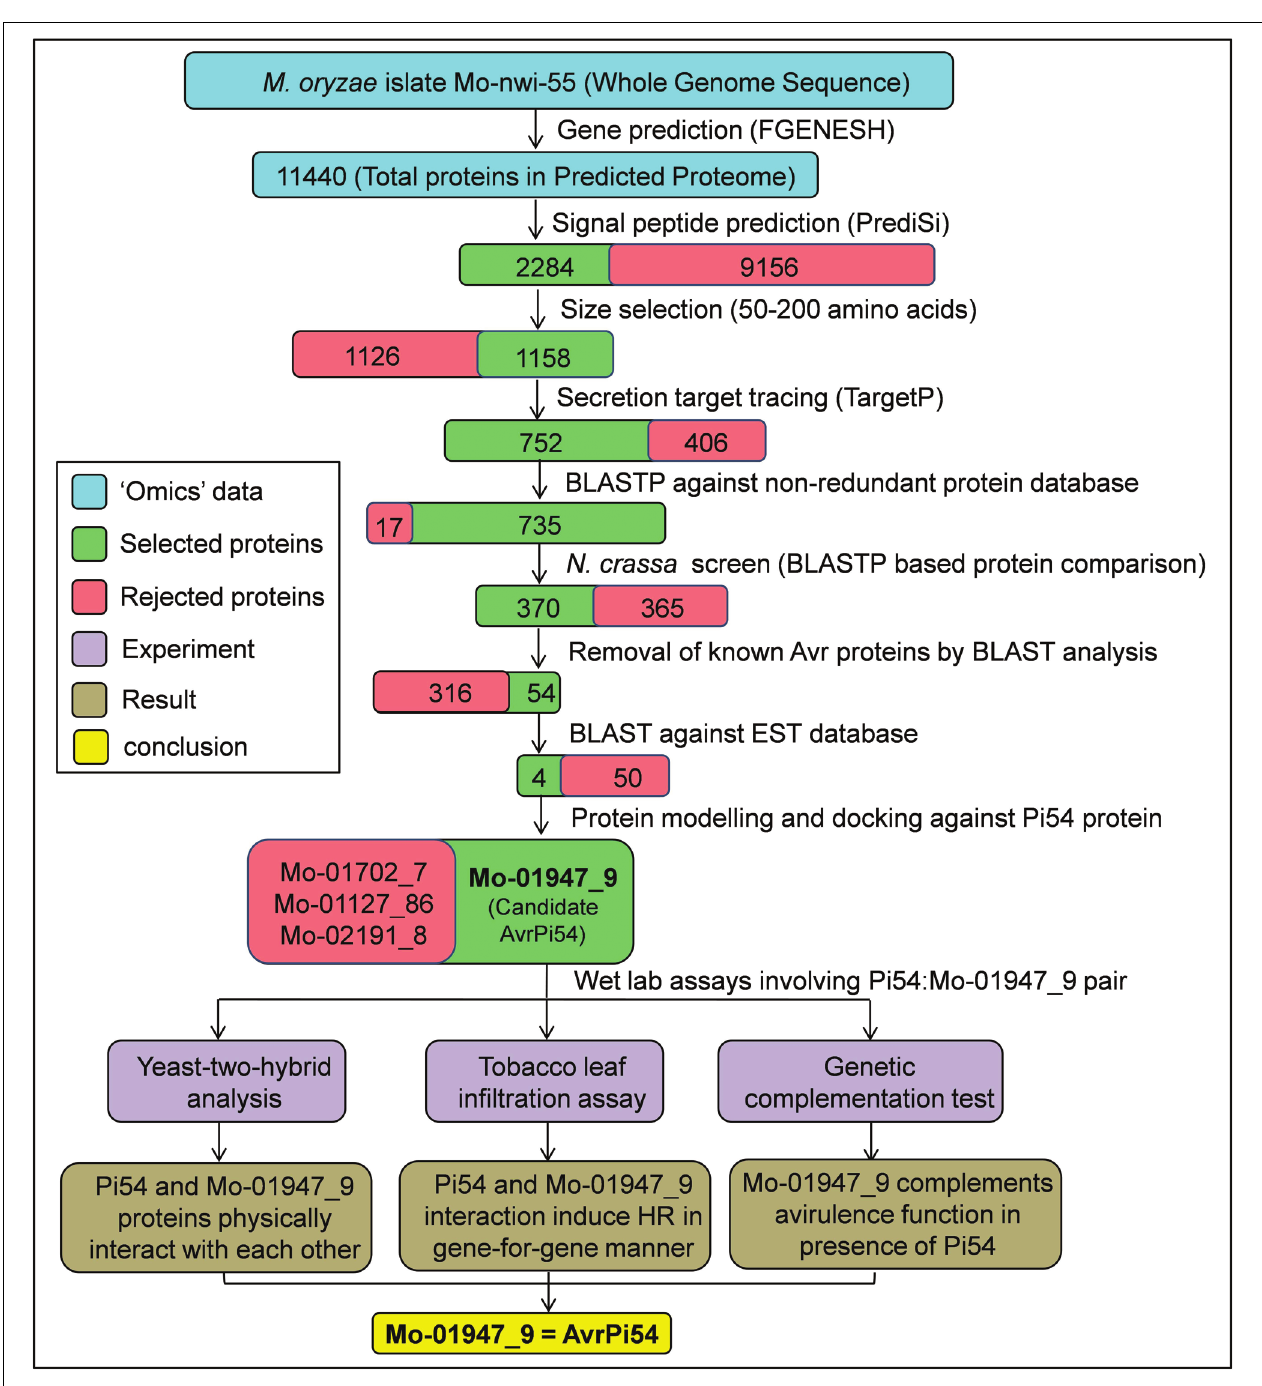
FIGURE 1 | Flow diagram summarizing the methodology for identification of AvrPi54 gene. Candidate AvrPi54 was identified in silico utilizing the whole genome sequence of M. oryzae isolate Mo-nwi-55 and was further validated through wet lab experiments.